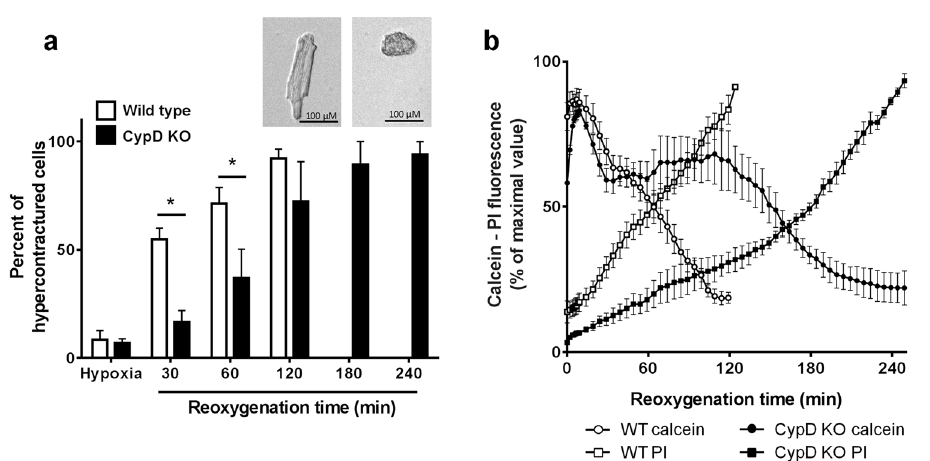
Figure 6. Effect of CypD deletion on hypercontracture, mPTP opening and cell death after 45 min hypoxia followed by reoxygenation in isolated adult mouse cardiomyocytes. Cardiomyocytes were isolated from wild type (WT) and CypD knock-out (KO) mice, were co-loaded with calcein, CoCl 2 and propidium iodide (PI) and were subjected to 45 min hypoxia and then reoxygenated. Images were collected every min during the first 5 min of reoxygenation and then every 5 min. ( a ) Percentage of cells exhibiting hypercontracture at the end of hypoxia and at different reoxygenation times. ( b ) Time course of mPTP opening and cell death during reoxygenation. Fluorescence was normalised to 100% of the maximal values. Traces from 3 to 5 experiments were